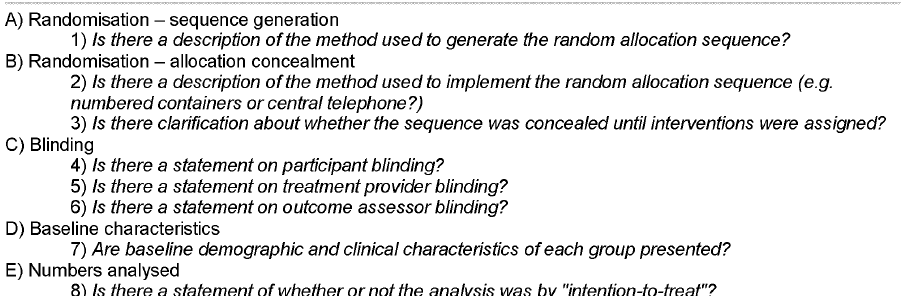
Figure 3. CONSORT checklist used to evaluate studies.